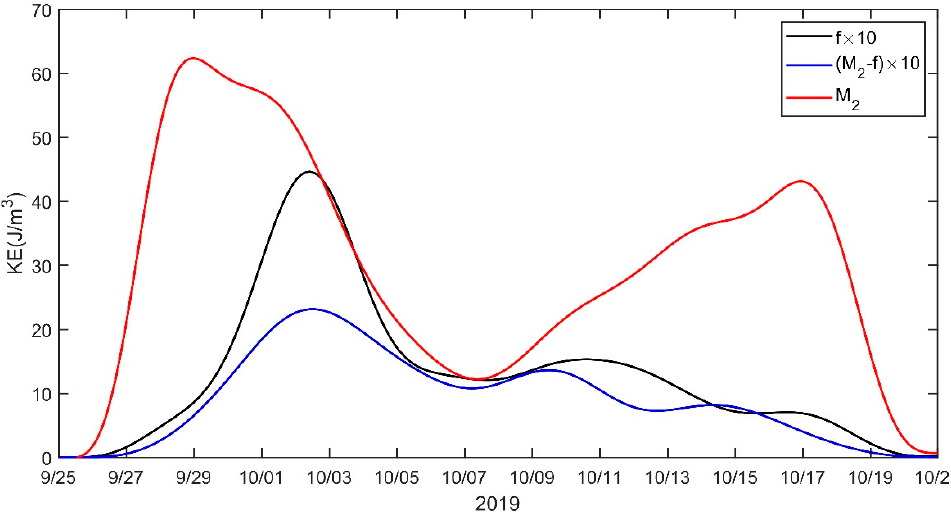
Figure 19. Twenty-four-hour low-pass filtered depth-averaged kinetic energy in the near-inertial (black), M 2 – f (blue), and M 2 (red) frequency bands. Note that the kinetic energy in the f and M 2 – f frequency bands is amplified by a factor of 10, referring to Cao et al. [75].